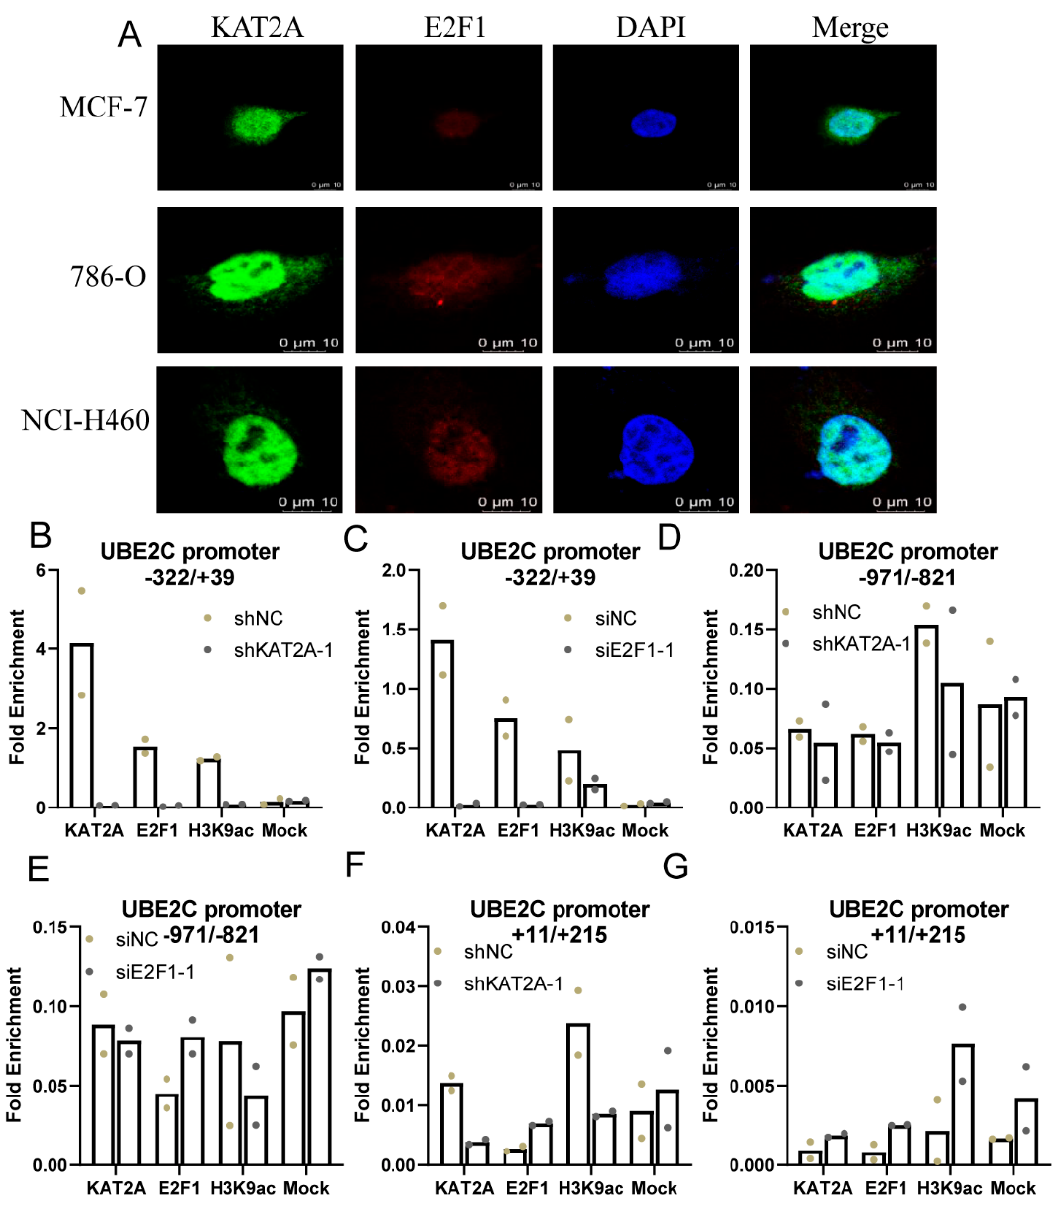
Figure 4. KAT2A and E2F1 bind to the UBE2C promoter in different cancer cells. ( A ) Cellular immunofluorescence showed the nuclear localization of KAT2A and E2F1 in MCF-7, 786-O, and NCI- H460 cells. ( B – G ) After interference with KAT2A and E2F1 and their corresponding NC, respectively, the enrichment of KAT2A , E2F1 , and H3K9ac on the UBE2C promoter. Data are representative from two independent experiments. N = 2. The bar graph represents mean values, and the dot plots of individual data points are overlaid on bar graphs.